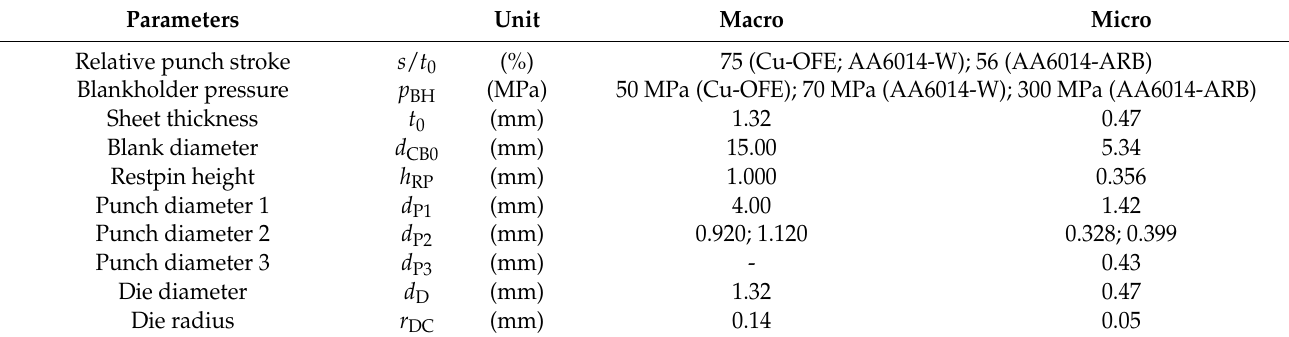
Figure 1. Investigated process chain with resulting part geometries of the different forming stages. Table 1. Process parameters for cold bulk macro- and microforming from sheet metal.